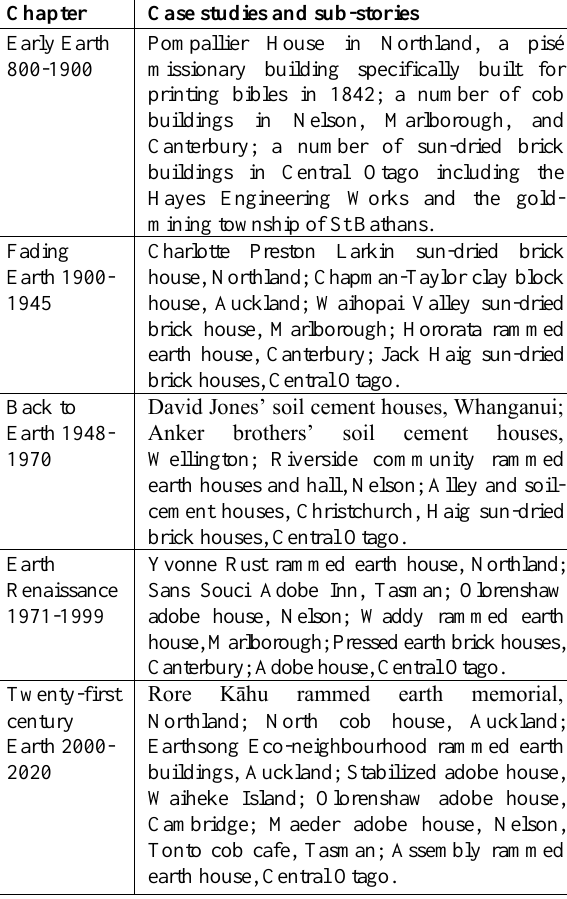
Table 6. Case studies for S1: chronological primary and regional secondary